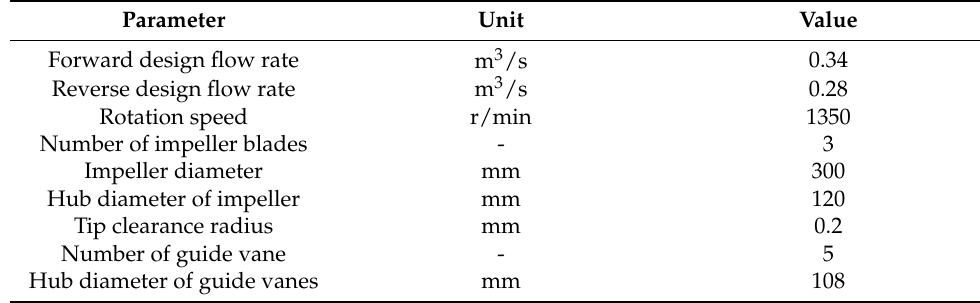
Figure 4. Three-dimensional modeling of original case. Table 2. Main geometry and design parameters of Original case.